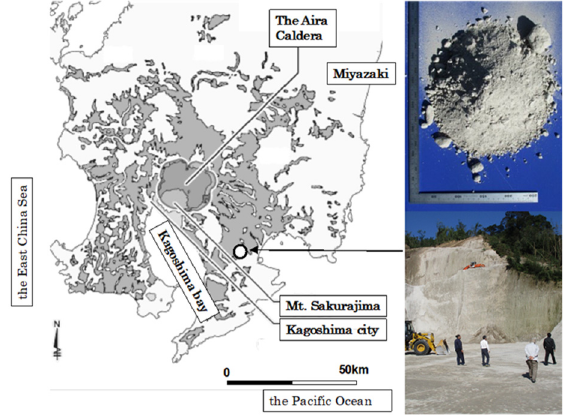
Figure 2. Distribution area of Ito‐shirasu and sample site.